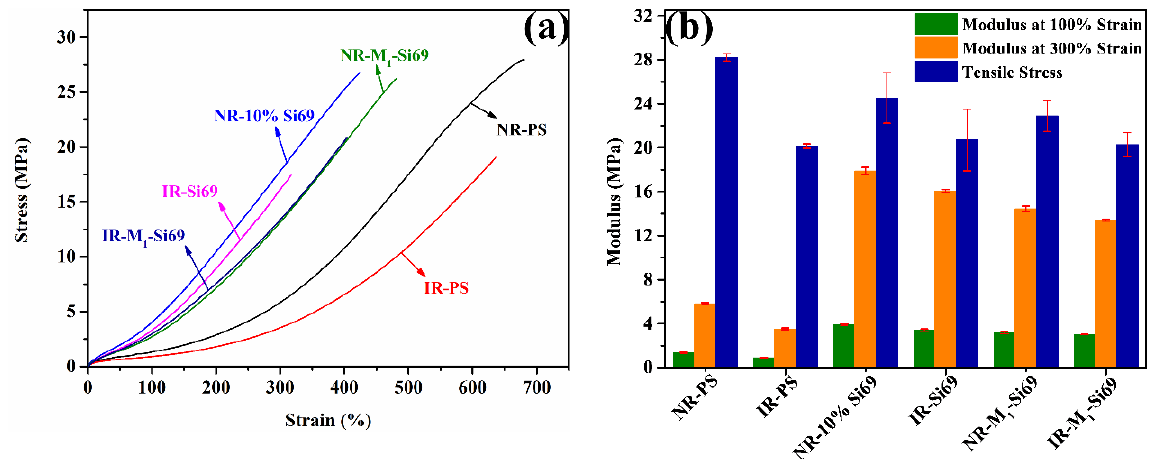
Figure 10. ( a ) Stress – strain curve; ( b ) modulus and tensile strength.